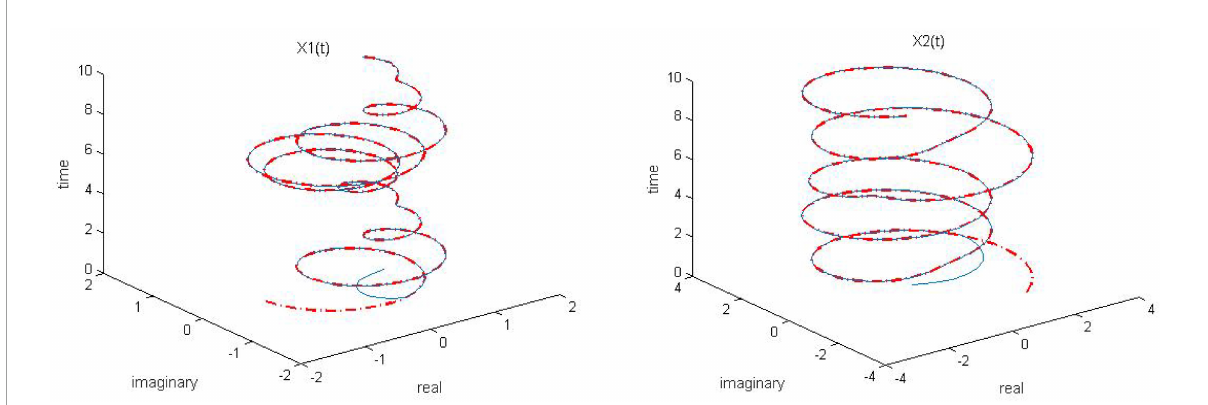
FIGURE1 Dynamic complex matrix equation (DCME) (1) solved by robust zeroing neural network (RZNN) model (10) with k = 0.5 in no noise environment.